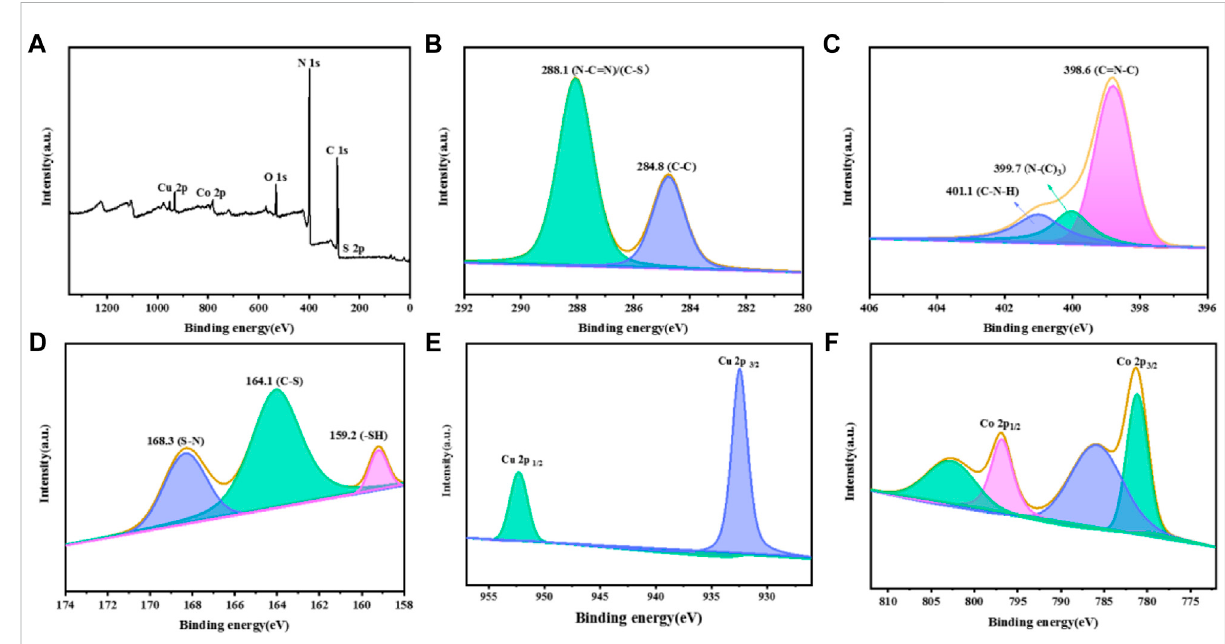
FIGURE 6 XPS patterns of the CuCo/SCN: (A) Survey, (B) C 1s, (C) N 1s, (D) S 2p, (E) Cu 2p, and (F) Co 2p.